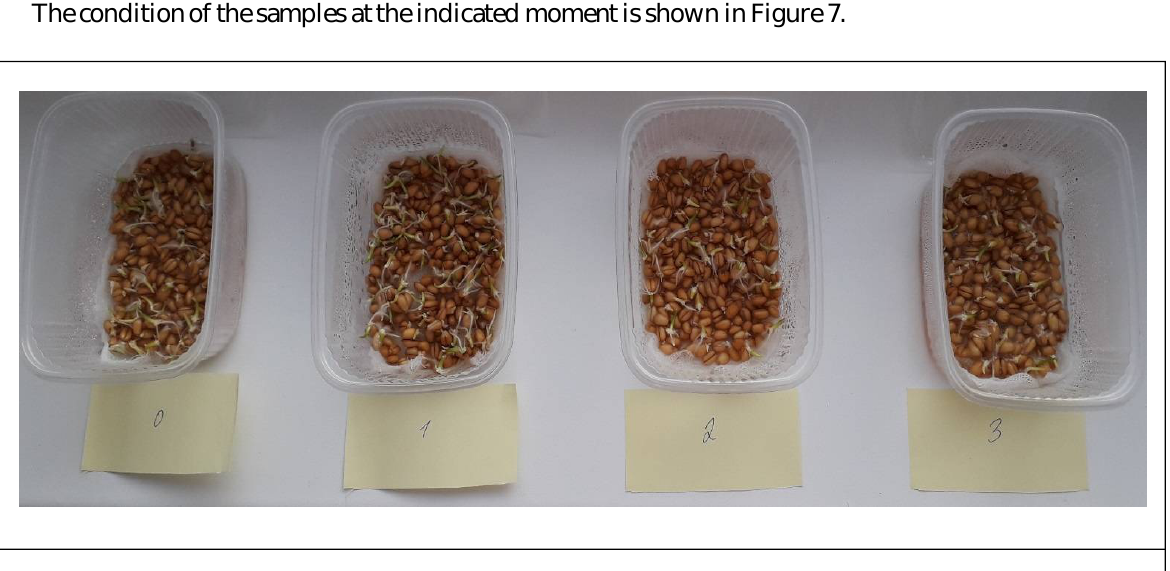
Figure 7: Tríticum durum on ordinary and magnetized water (August 7,